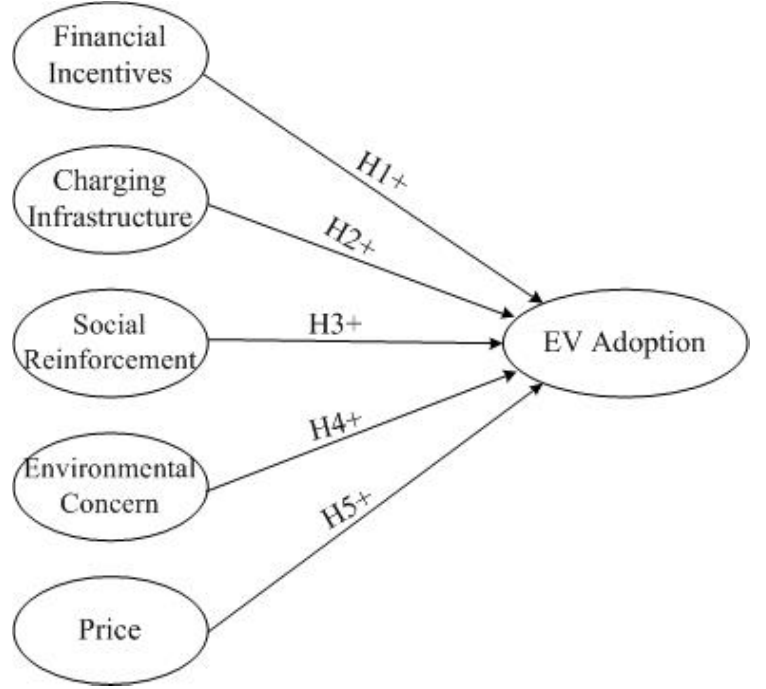
Figure 1. Proposed Research